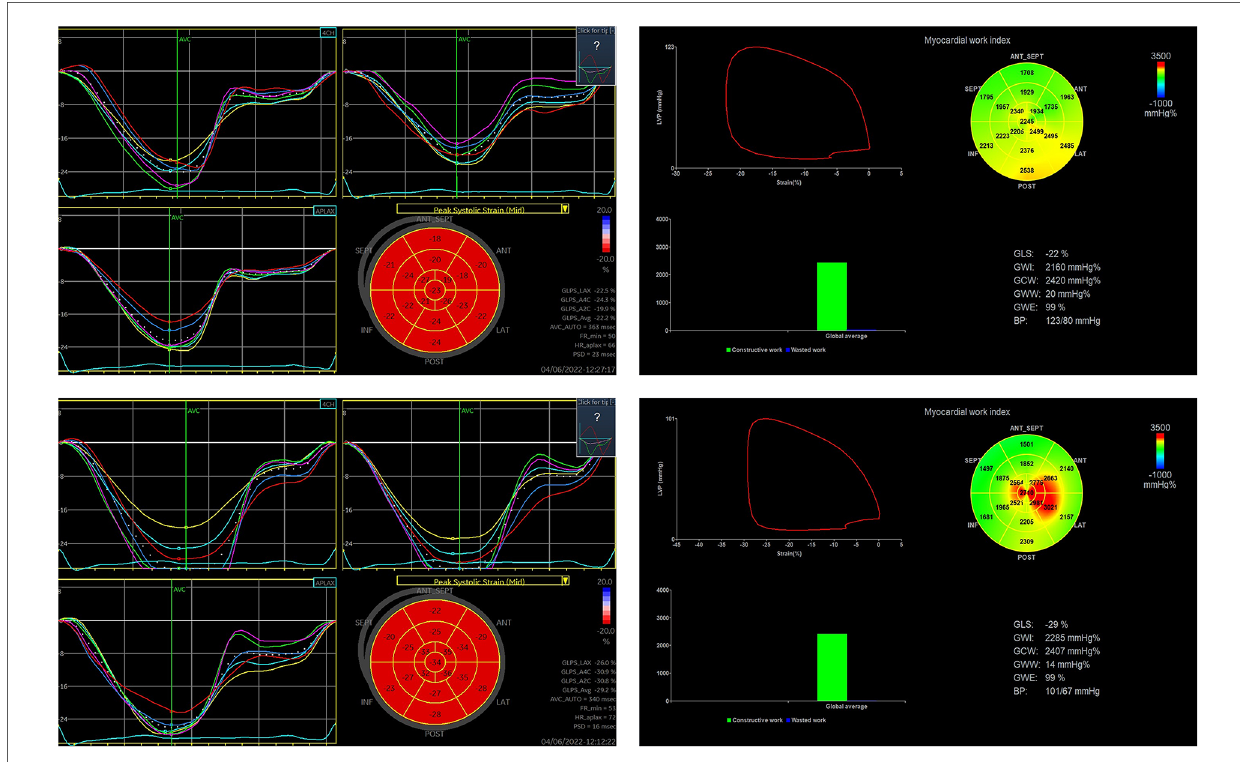
FIGURE 2 Changes in 2D-STE-related indexes and MW before and after adenosine stress in a patient in the non-CMD group. (The upper row shows 2D-STE related indices and MW at rest and the lower row shows 2D-STE related indices and MW at stress in ANOCA patient without CMD.) (This patient was a 57-year-old woman, 1.68 m tall, 65 kg, with a blood pressure of 123/80 mmHg before and 101/67 mmHg after adenosine stress, who was treated with aspirin, statin and metoprolol before